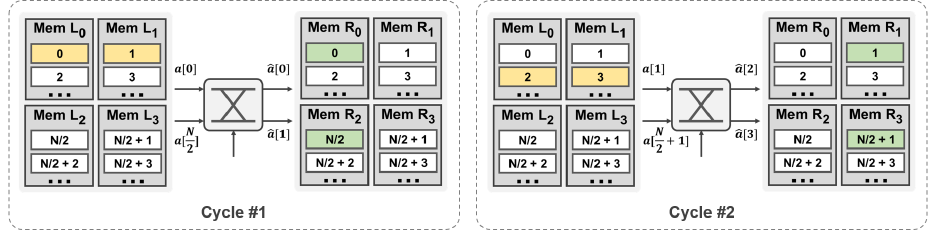
Figure 6: Data-flow of our NTT memory architecture in the first two cycles (butterfly inputs are in yellow and outputs are in